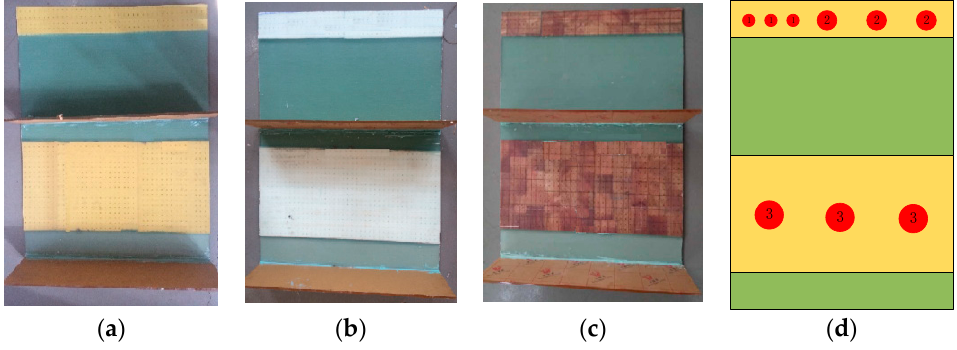
Figure 2. Experimental samples: ( a ) PVC; ( b ) PET; ( c ) balsa wood; ( d ) nickel chrome wire position. Table 1. Material parameters.